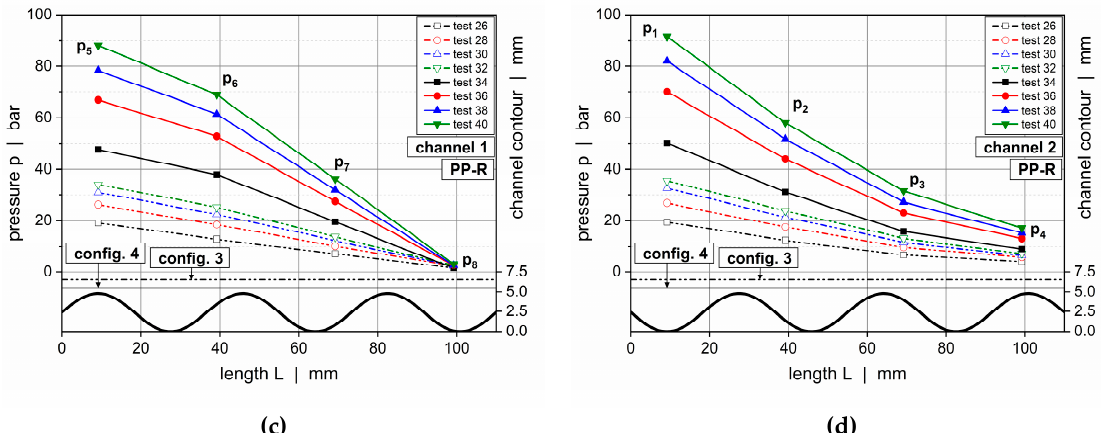
Figure 14. Downchannel pressure profiles along channel 1 and 2 for various test configurations: channel 1, HDPE, configuration 2 versus configuration 3 ( a ); channel 2, HDPE, configuration 2 versus configuration 3 ( b ); channel 1, PP-R, configuration 3 versus configuration 4 ( c ); and channel 2, PP-R, configuration 3 versus configuration 4 ( d ).